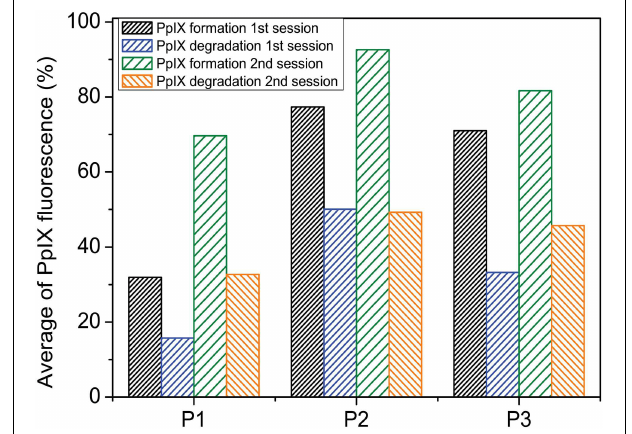
FIGURE 4 | Mean value of red pixels in fluorescence images of different patients (P1, P2, and P3), comparing the formation and degradation in the first and second PDT sessions.